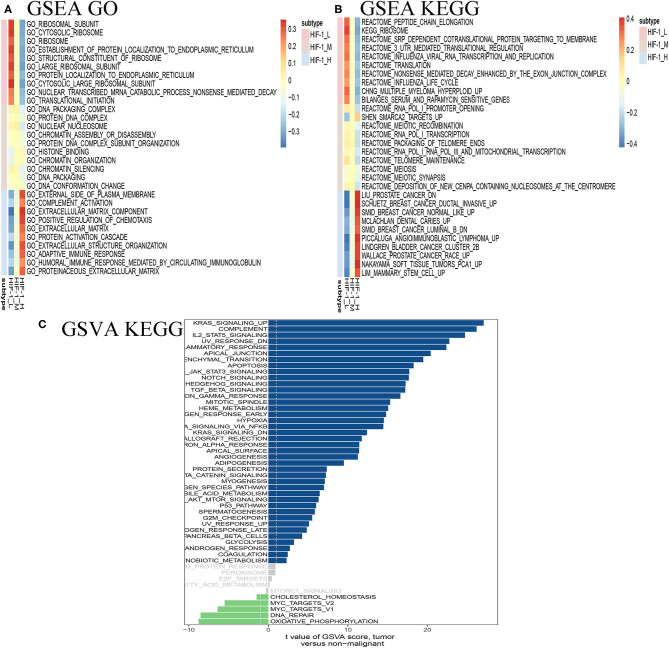
Identification of PCa subtype-specific up-regulated GO (A) and KEGG (B) among three PCa subtypes using the GSEA method in the TCGA dataset. (C) GSVA reveals the disparity in the KEGG pathway between the HIF-1_L and HIF-1_H subset in the TCGA dataset.